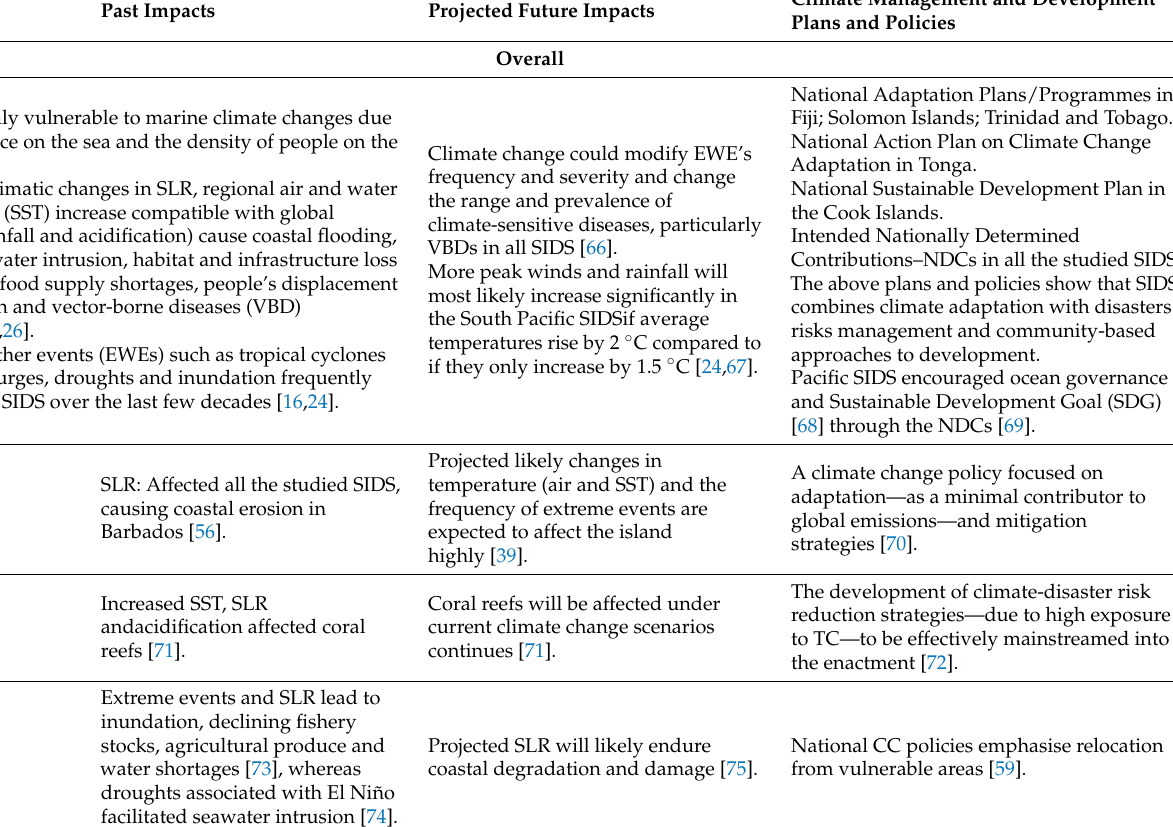
Table 3. Examples of past and projected future impacts and plans/policies on the investigated SIDS: Barbados, Trinidad and Tobago, The Cook Islands, Fiji, Solomon Islands and Tonga. Past Impacts Projected Future Impacts